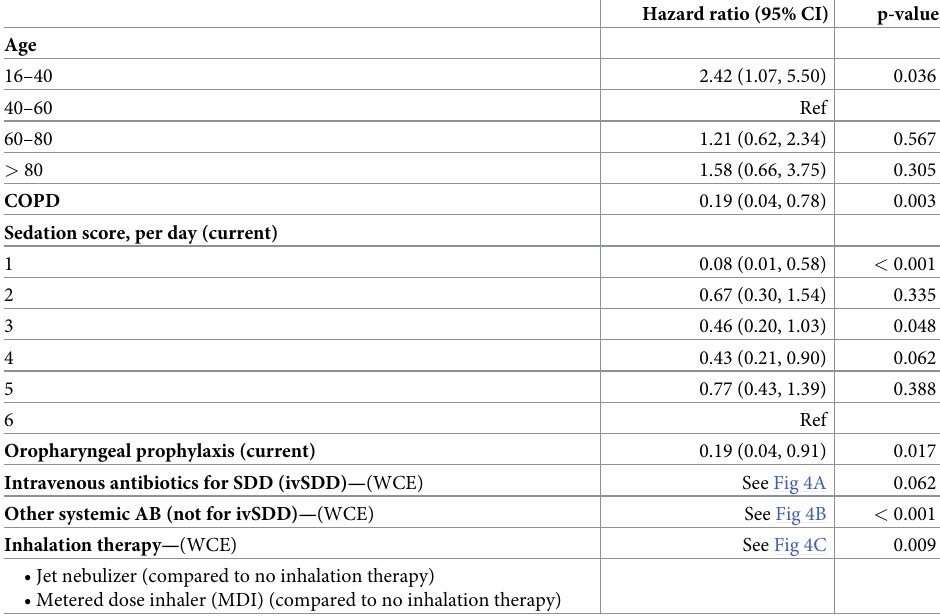
Table 3. Hazard ratios of patient and ventilation characteristics–results of multivariate